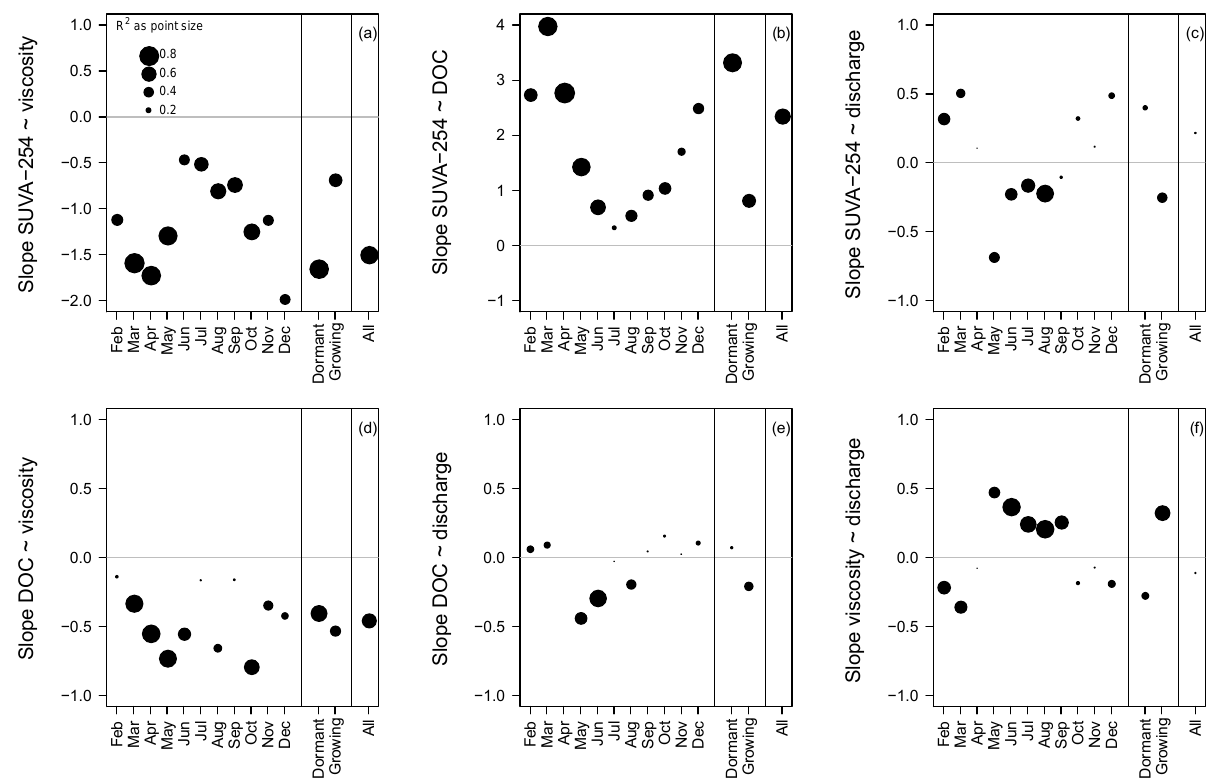
Figure 5. Slope and explained variance ( R 2 ) of the linear regression between the 15min anomalies of the four variables. Slope and R 2 are separately calculated for each month, for the dormant and the growing season, and for all values. All the p values are generally highly significant. Only rainless days with diel fluctuations and without the influence of rainfall–runoff events are shown (corresponding to the days in Fig.